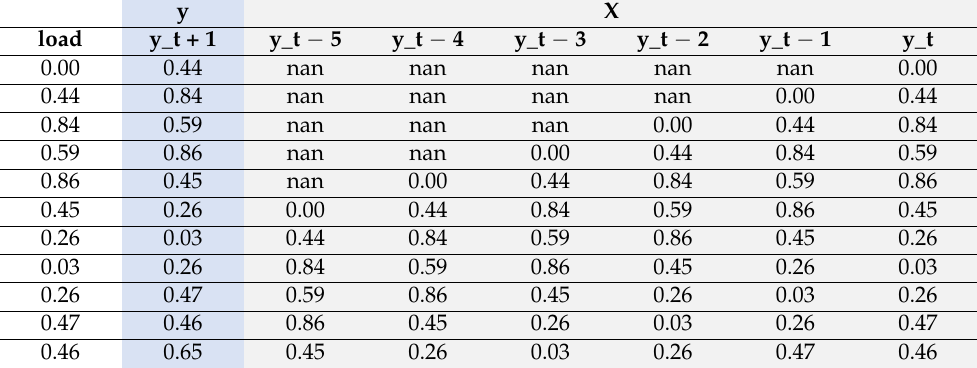
Table 9. Serial data for LSTM.